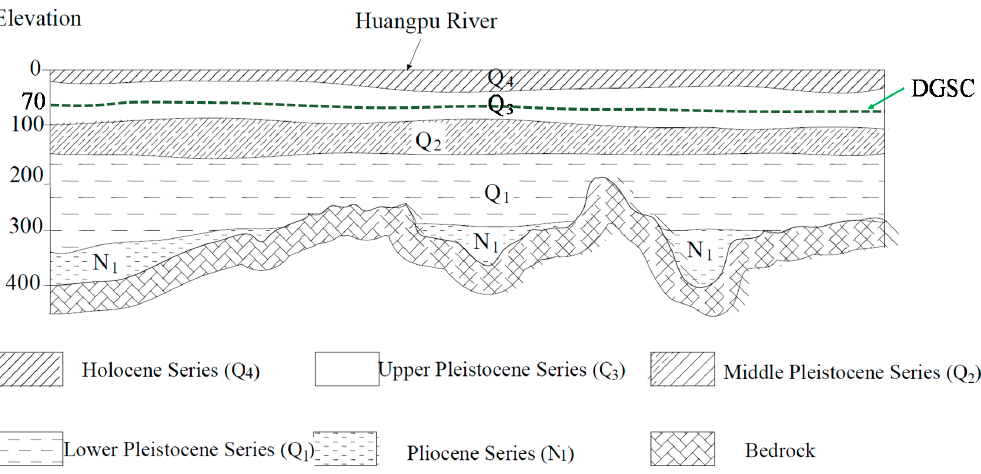
Figure 1. The typical Quaternary geological strata of Shanghai City (based on Xu, et al [48]). Shanghai locates on a flat alluvial plain by the East China Sea, composed of Quaternary sediments of Yangtze River estuary. It has a humid subtropical climate and experiences four distinct seasons. The annual mean temperature is around 16 °C without much difference between highest and lowest. It lasts almost 69 days in spring, 62 days in autumn (both 10 °C~22 °C), 117 days in